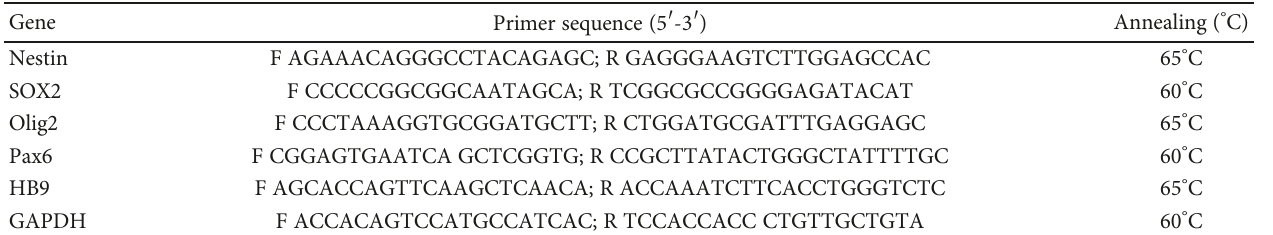
Table 1: Primers used for reverse transcription polymerase chain reaction